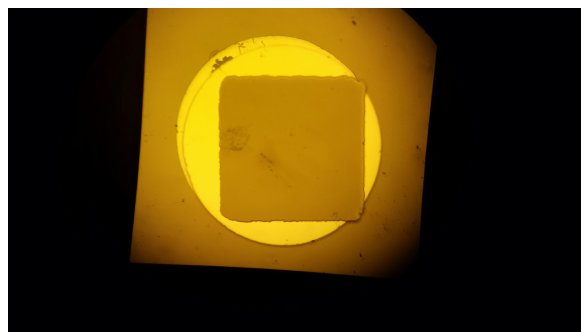
Figure 9. The diamond detector with wire glued to the electrode by silver resin (first detector)